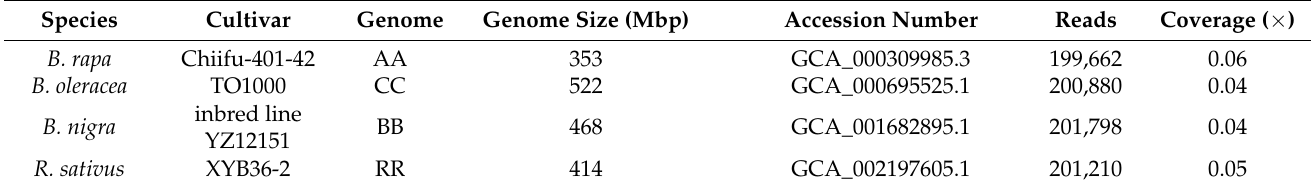
Table 1. Description of Brassica and Raphanus next-generation sequencing reads used to generate the microsatellites and summary of the coverage.